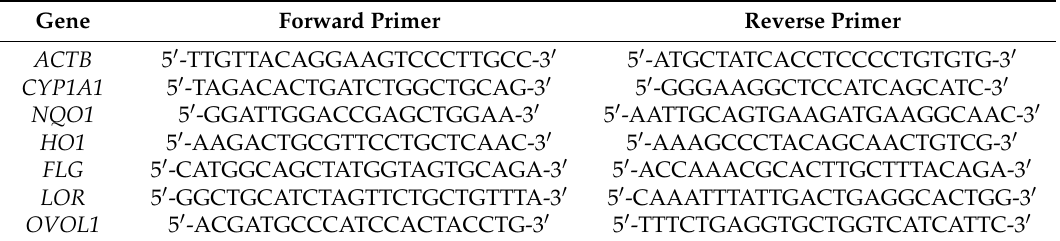
Table 1. Primers for PCR (Polymerase Chain